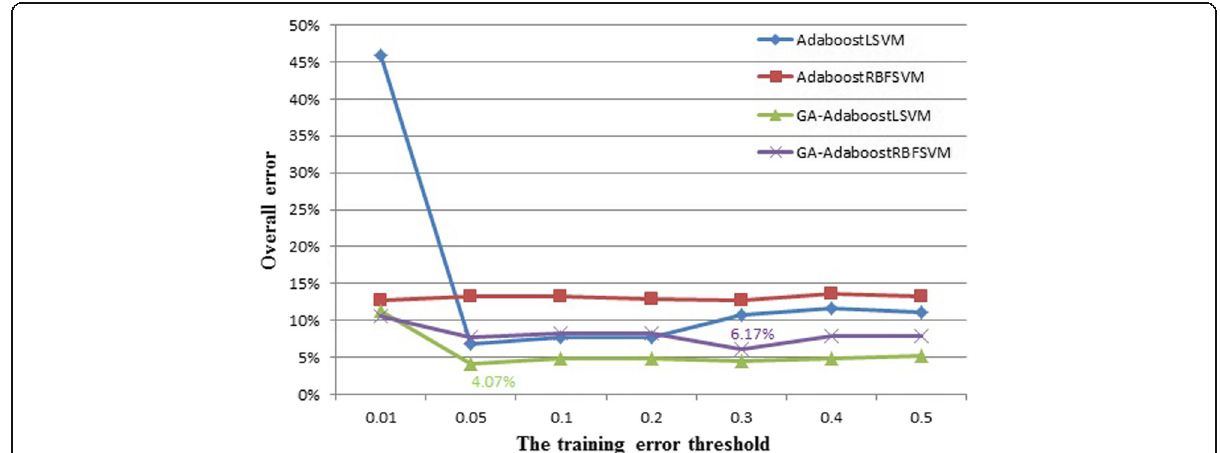
Fig. 10 The minimum overall error rate of different classifiers at different training error